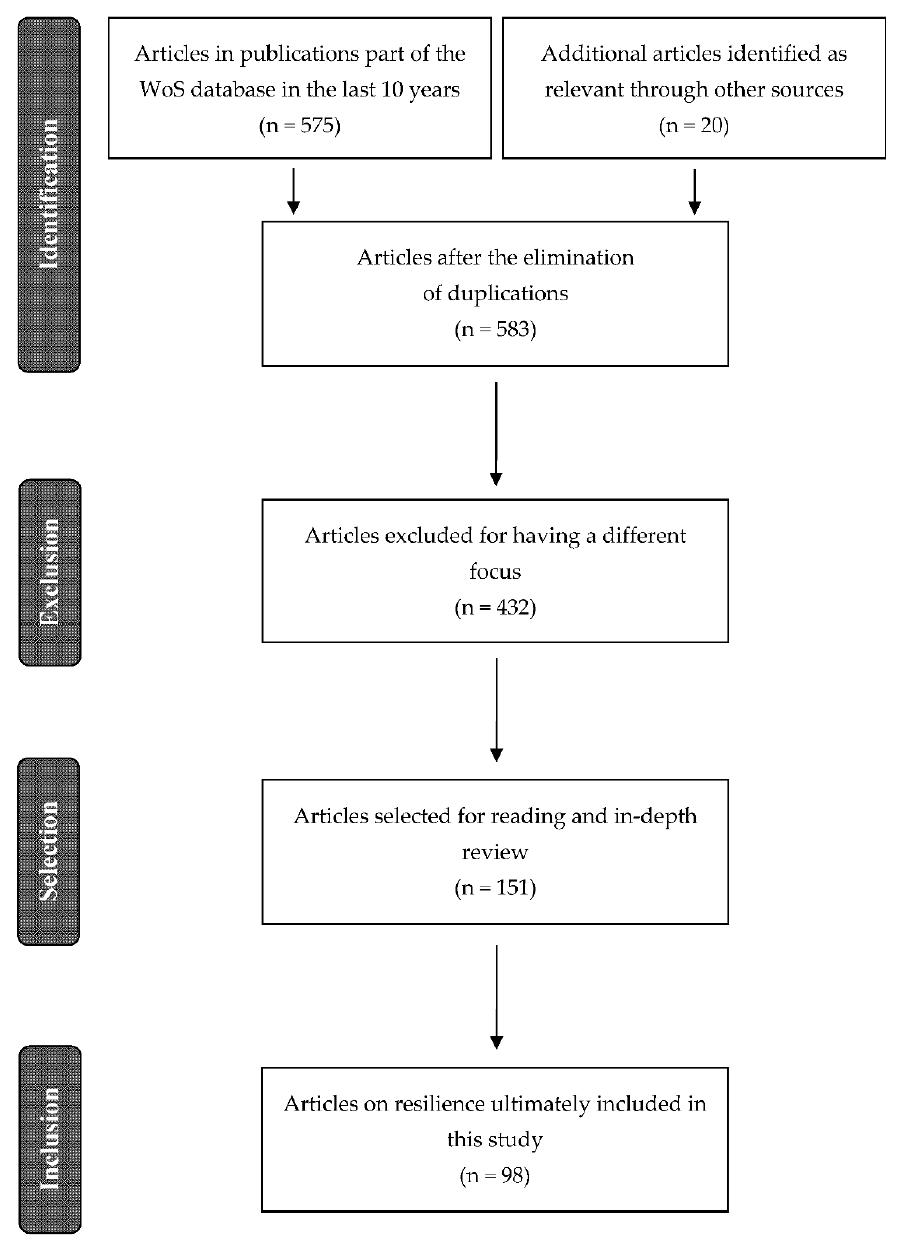
Figure 1. PRISMA flowchart of the bibliographical selection process.